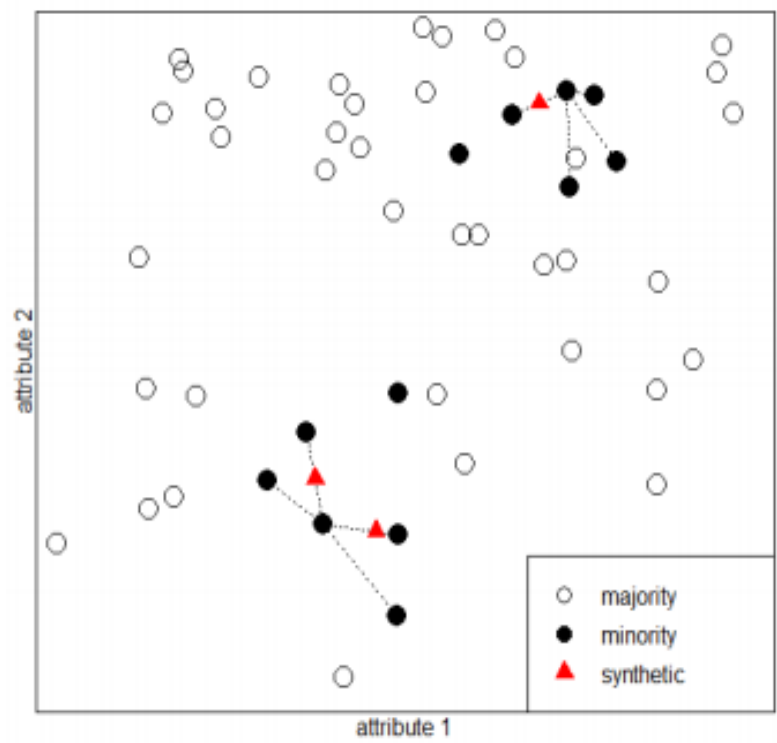
Figure 5. SMOTE application with K =